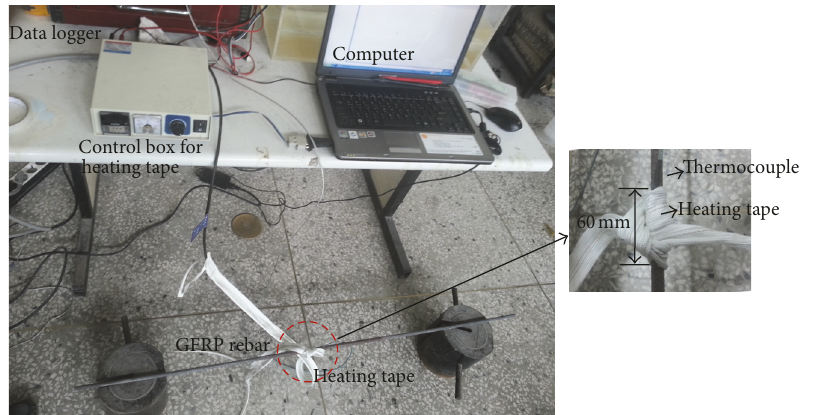
Figure 2: Preheating of GFRP reinforcement bars.